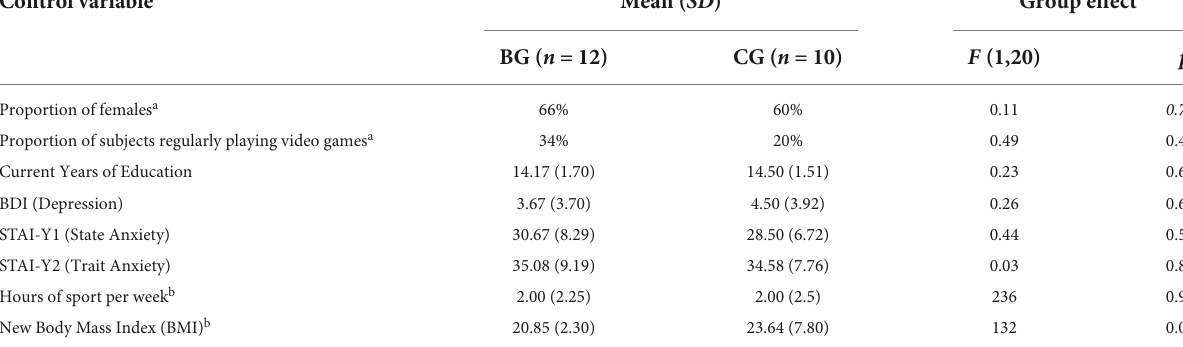
TABLE 1 Participant